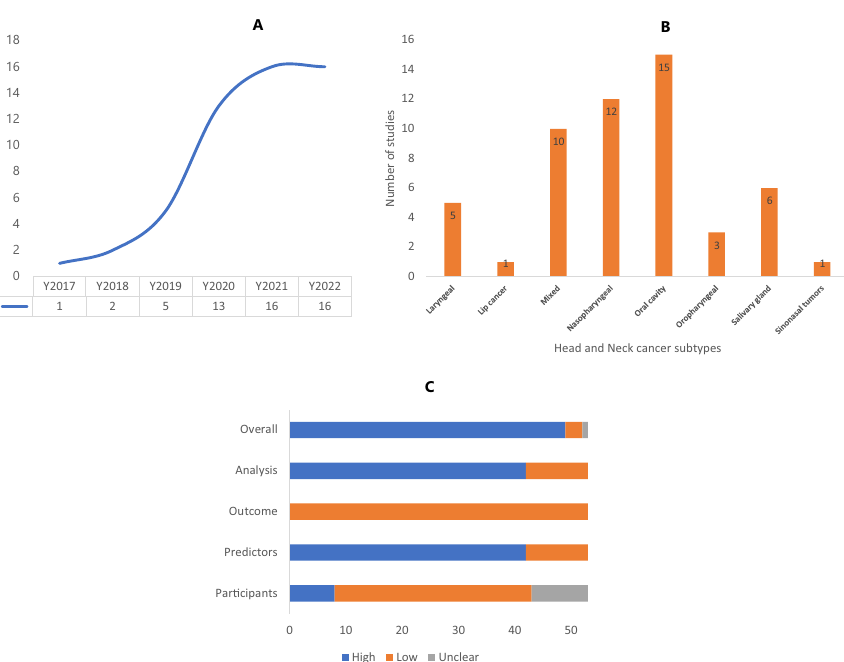
Fig. 4 General characteristics and risk of bias rating for ML studies employing unstructured datasets. a Publication year trend b Plot showing the number of patient datasets by the different head and neck cancer subtypes c Risk of bias rating for individual domains of the PROBAST